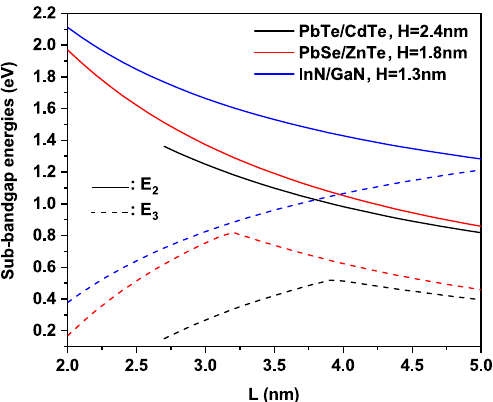
Figure 4. Variation of the sub-band gap energies E 2 (solid lines) and E 3 (dashed lines) versus dot size L at the optimum inter-dot spacing H = 2.4 nm, 1.8 nm and 1.3 nm for PbTe/CdTe, PbSe/ZnTe and InN/GaN QD materials.